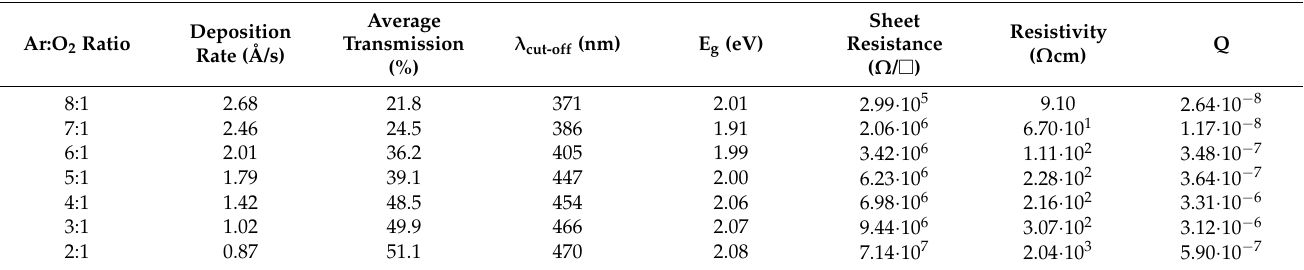
Figure 4. Results of: ( a ) transmission spectra of V x O y thin films deposited with various Ar:O 2 gas ratios during the magnetron sputtering process and ( b ) the average transmission of vanadium oxides in the VIS wavelength range. Table 1. Summary of the properties of deposited vanadium oxide thin films prepared with various Ar:O 2 gas ratios during magnetron